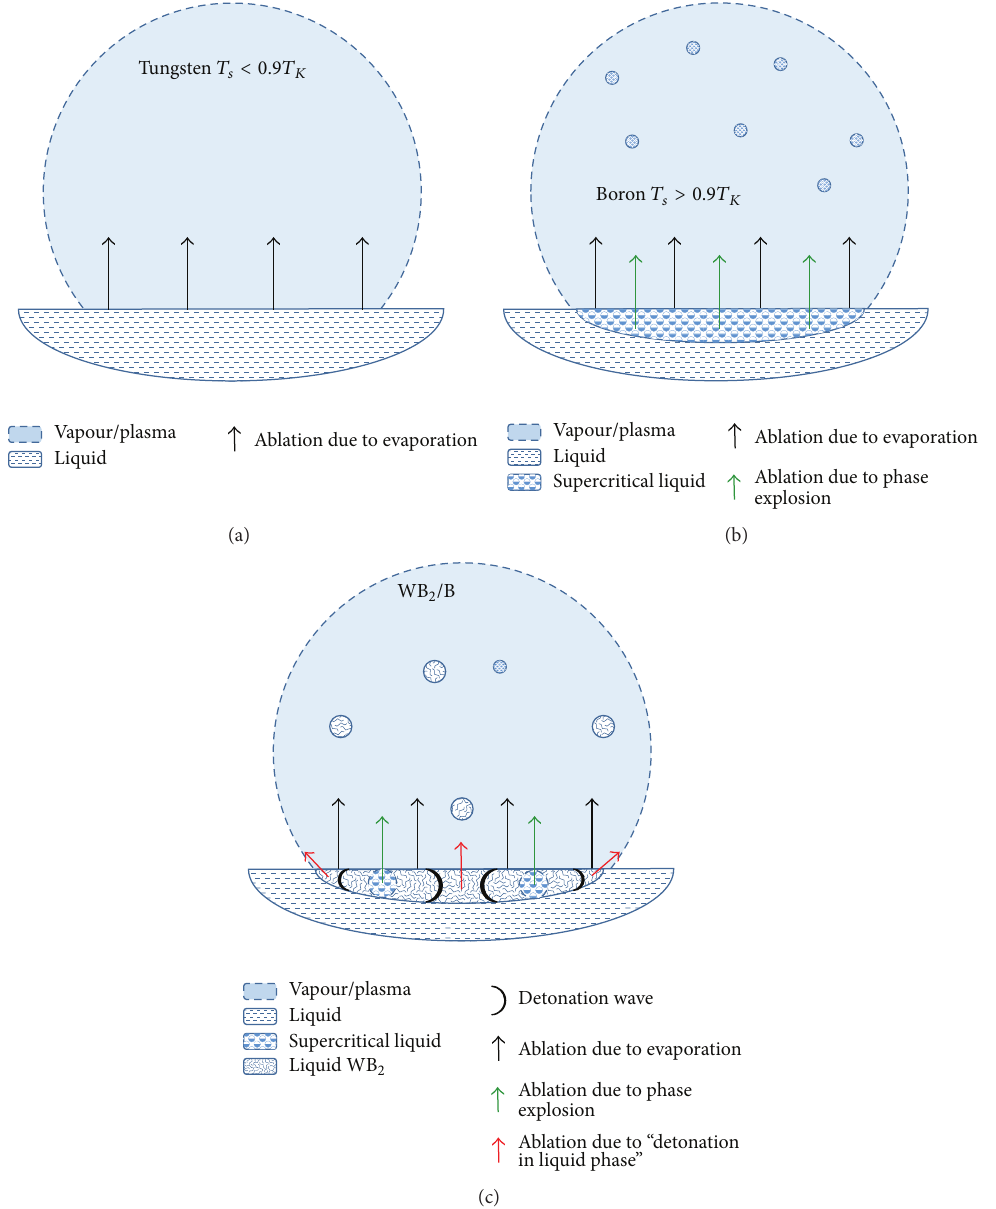
Figure 10: The comparison of ablation mechanisms: (a) evaporation, (b) phase explosion, and (c) “detonation in liquid phase.”